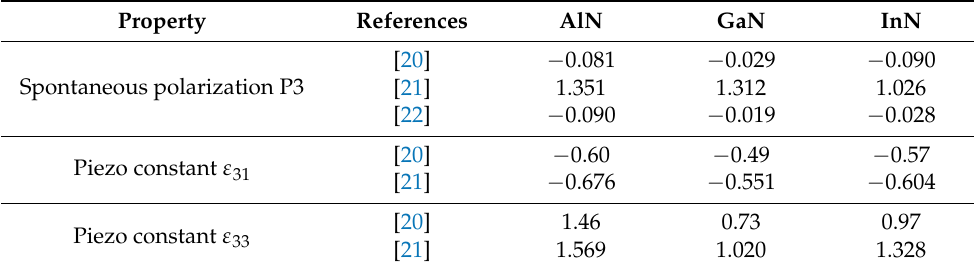
Table 1. Spontaneous polarization and piezoelectric constants published previously (in C/m 2 ).